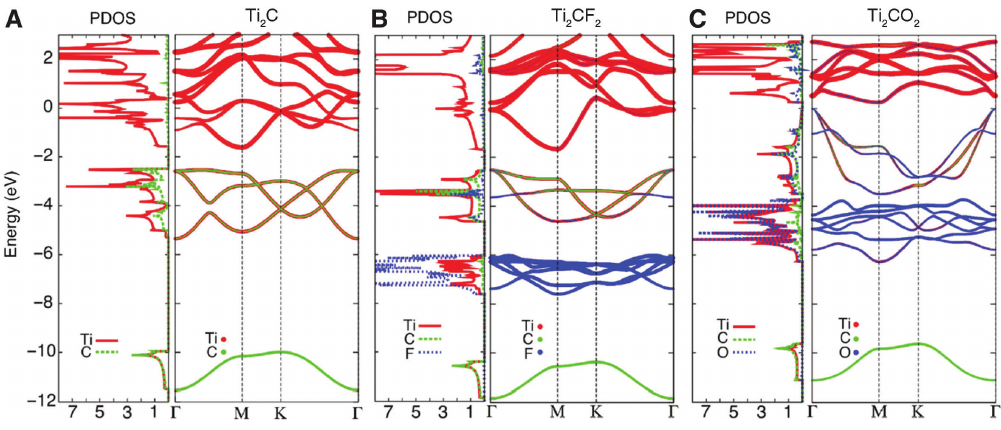
C, (B) Ti CF , and (C) Ti CO . 2 2 2 2 2